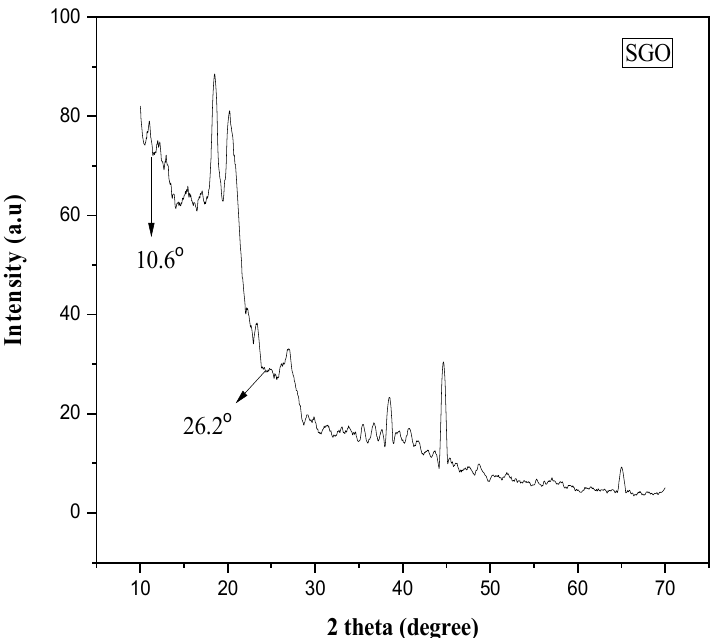
Figure 3. XRD spectrum of sulfonated graphene oxide. Fourier transform infrared spectra of PVDF membranes in Figure 4 shows absorption bands at 3023, 1628, 1401, 1276, 1181, 975, 1070, 796, 762, 841, 573 and 613 cm − 1 . The existence of PVDF was recognized by a peak present at 1169 cm − 1 for C–F stretching vibration as shown in Figure 4. The vibration peak observed at 1402.45 cm − 1 was related to the bending vibration of the CH 2 group and the vibration band present at 1071 cm − 1 confirmed the presence of β crystalline segment of polyvinylidene fluoride. The vibrational bands present at 877 and 837 cm − 1 were related to the rocking mode of vinylidene moiety of polyvinylidene fluoride. The bands that exist at 598 cm − 1 were caused by bending vibration of the CF 2 group [28].